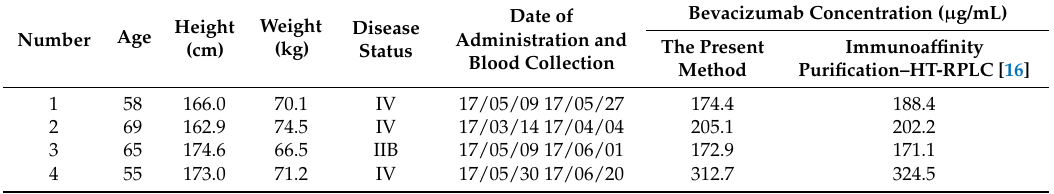
Table 2. Clinical characteristics of four male patients with lung cancer and plasma concentrations of bevacizumab analyzed by the present method and the immunoaffinity purification–HT-RPLC